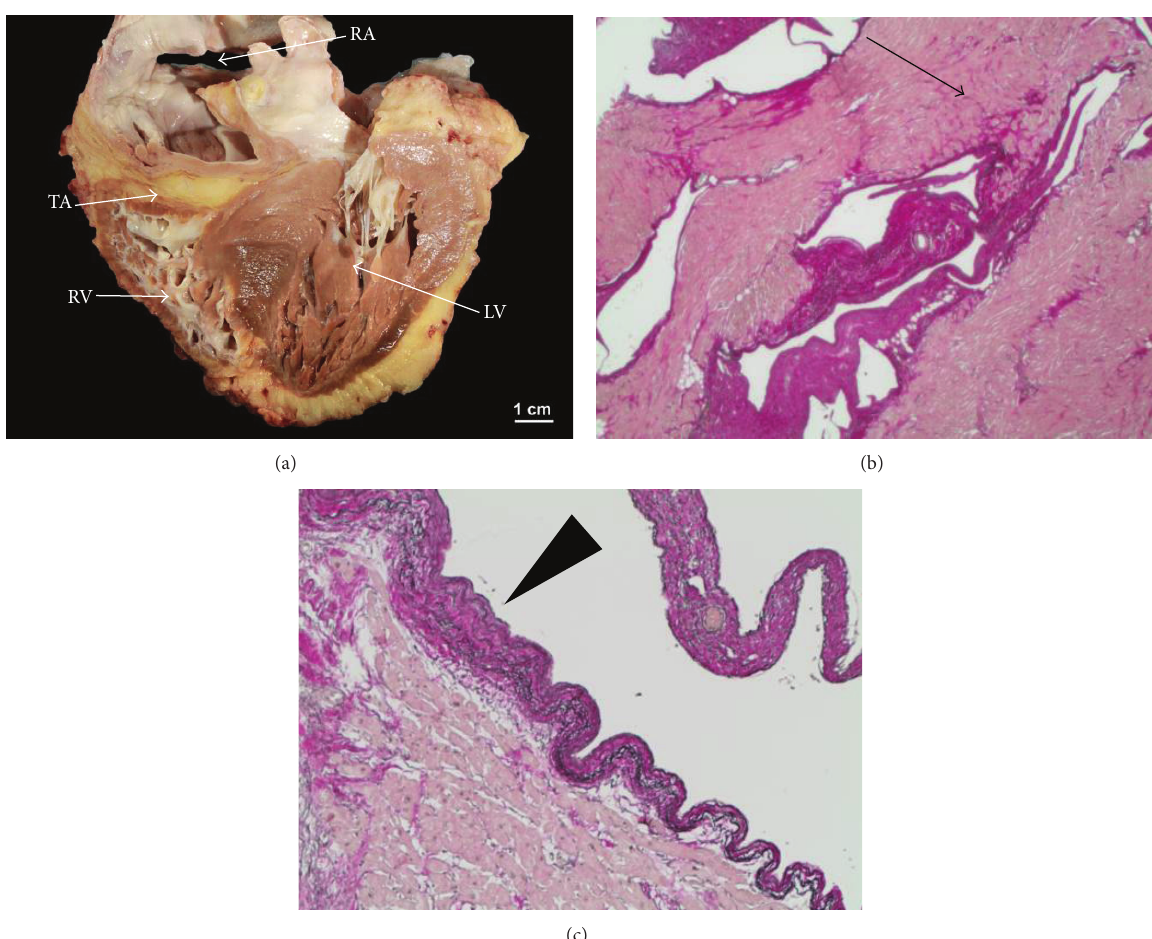
Figure 2: Explanted heart of a 31-year-old patient with failing Fontan. (a) Macroscopic view of the explanted heart, showing the tricuspid atresia (TA) with hypoplastic right ventricle (RV), grossly dilated right atrium (RA) and left ventricle with septal hypertrophy. (b) and (c) show histologic cuts of the right ventricular myocardium with areas of interstitial myocardial fibrosis (arrow) and areas of marked endomyocardial fibroelastosis (arrow